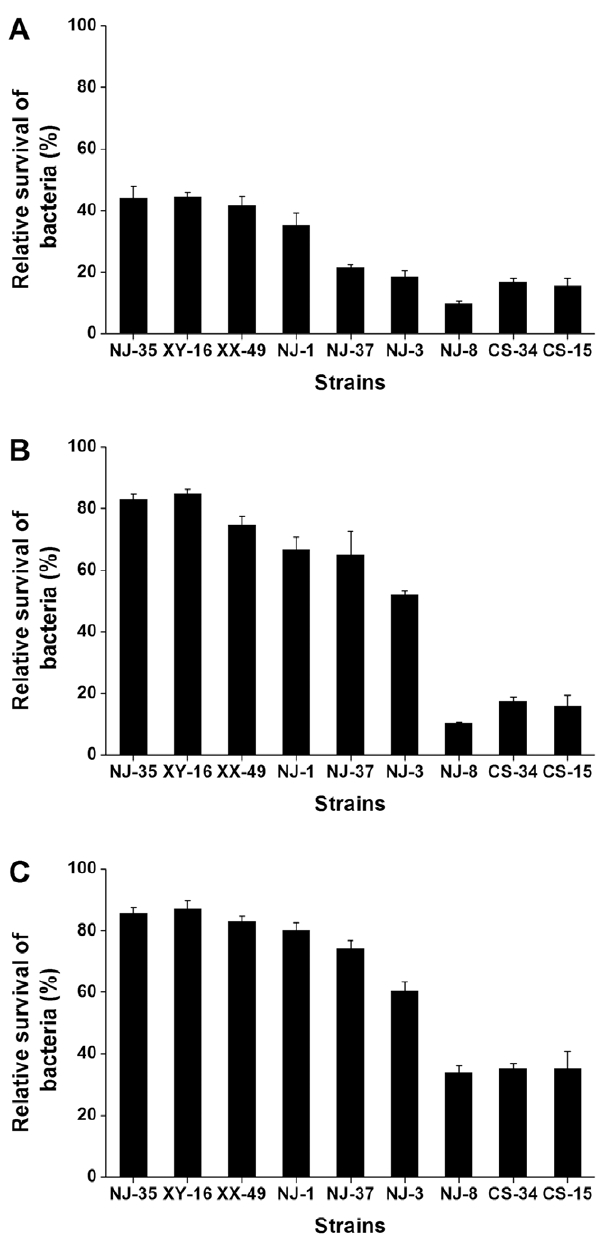
Figure 1. Relative survival of nine Aeromonas strains co- cultured with T. thermophila in three different proportions. Relative survival of each bacterium at 12 h is expressed as the number of Aeromonas CFU in the co-culture with T. thermophila relative to the number of Aeromonas CFU grown alone. At the start of the experiment, T. thermophila was at 1 6 10 5 cells/ml while the Aeromonas spp. was at 1 6 10 8 CFU/ml (A), 5 6 10 8 CFU/ml (B) and 1 6 10 9 CFU/ml (C), respec- tively. Error bars represent standard deviations from four independent experiments, with each experiment being comprised of four individual measurements. the LD 50 s increased. The Pearson correlation coefficient between relative survival of Aeromonas and the LD 50 s of these strains in zebrafish was 2 0.683 (P , 0.01); thus, the correlation is categorized as moderate according to Munro [22]. The resulting regression equation to calculate relative survival is as follows: